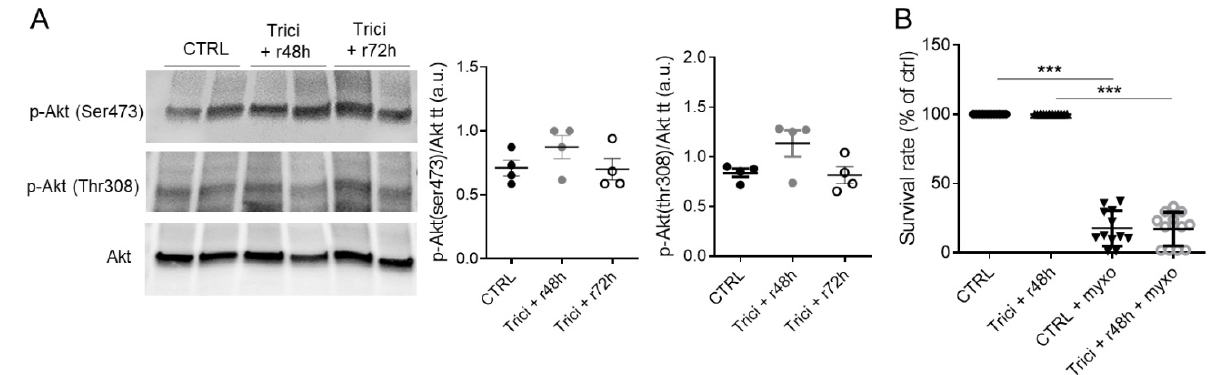
Figure 6. Reversibility of triciribine treatment. Akt phosphorylation and myxothiazol induced cell death were assessed after 24 h triciribine treatment (1 µ M) followed by 2 washes and either a 48 (r48 h) or 72 (r72 h) h recovery period. Control cells were stopped at 48 h after media change. ( A ) Phosphorylation of Akt on both Ser(473) and Thr(308) sites were assessed by western blot as well as total Akt proteins. Representative WB and related ratio analysis of p-Akt/Akt band intensities values along with mean ± SEM. n = 3. ( B ) Control or 48 h recovery cells were treated for 24 h with 1 µ M myxothiazol and survival rate was evaluated using a live/dead fluorescence assay. Scatter plot represents individual values along with mean ± SD. n = 12. *** p < 0.001.